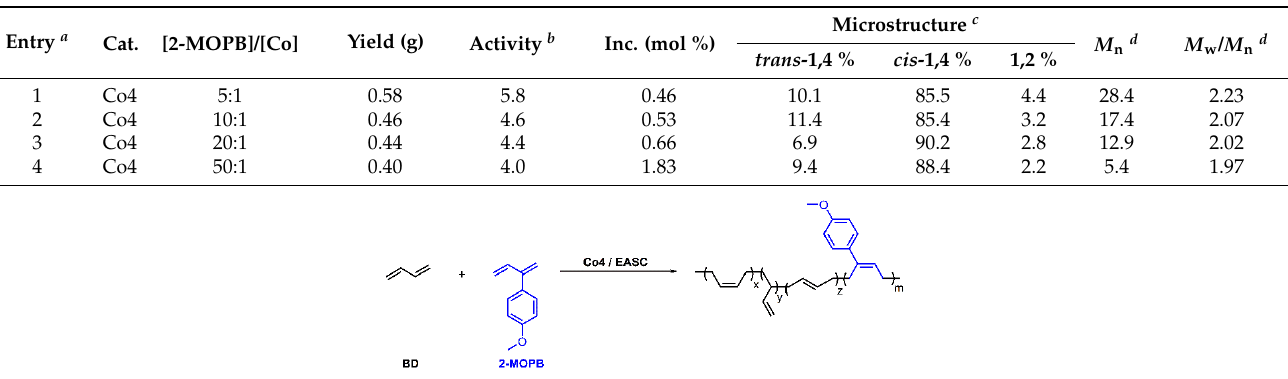
Table 2. The copolymerization of 2-MOPB with BD using Co4 .